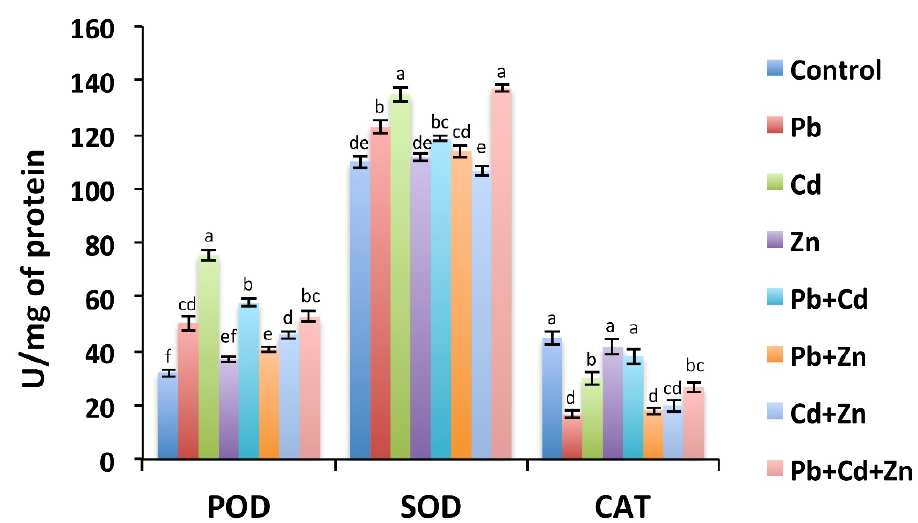
Figure 2. The activities of Peroxidase (POD), Superoxide dismutase (SOD), and Catalase (CAT) do not di ff er much between Pb / Cd / Zn applied alone and in combinations. The results shown are the average of three biological replicates. Bars represent mean ± SD. The values marked with di ff erent letters are statistically di ff erent ( p ≤ 0.05), while the values marked with the same letters do not di ff er